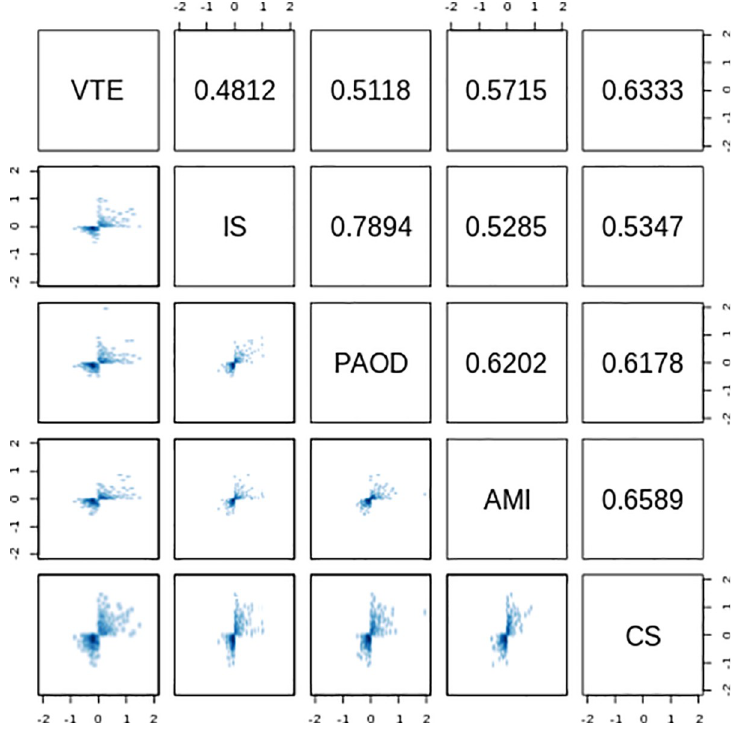
Fig 1. Correlation of gene expression changes between Venous Thromboembolism (VTE). Ischemic stroke (IS). Peripheral arterial occlusive disease (PAOD). Acute myocardial infarction (AMI) and Cardioembolic stroke (CS). Pairwise correlation scatter plots are in the lower triangle boxes. The upper triangle boxes show Pearson correlation coefficients (R) of log2 fold changes for all 472 differentially expressed genes between studies.